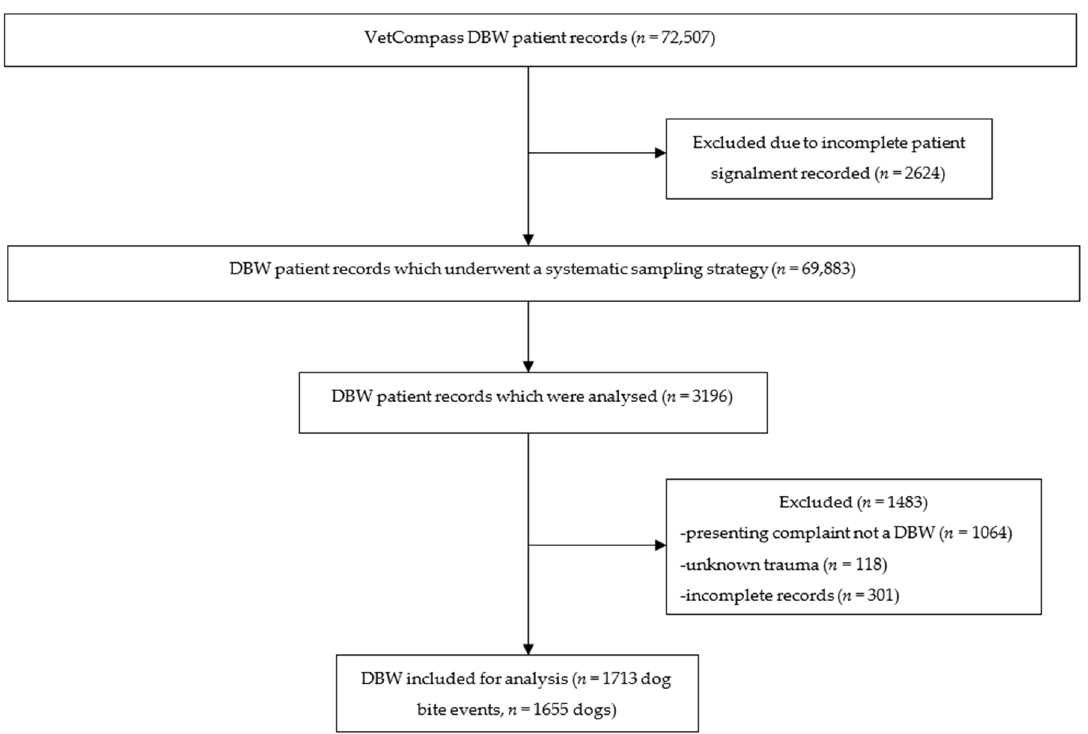
Figure 5. Flow diagram of the methodology of data collection for analysis of patients presenting for dog-to-dog bite wounds in the VetCompass Australia database from